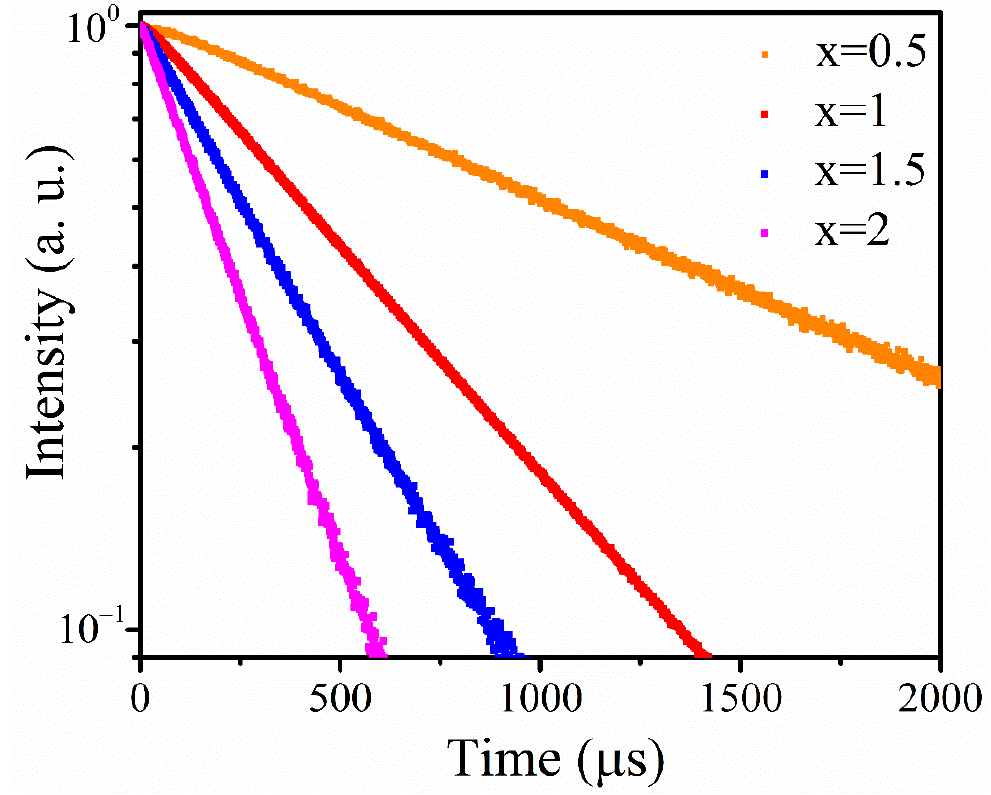
Figure 3. Fluorescence decay curves of Tm 3+ : 3 F 4 energy level monitored at 1808 nm in TGBT-x glass samples.